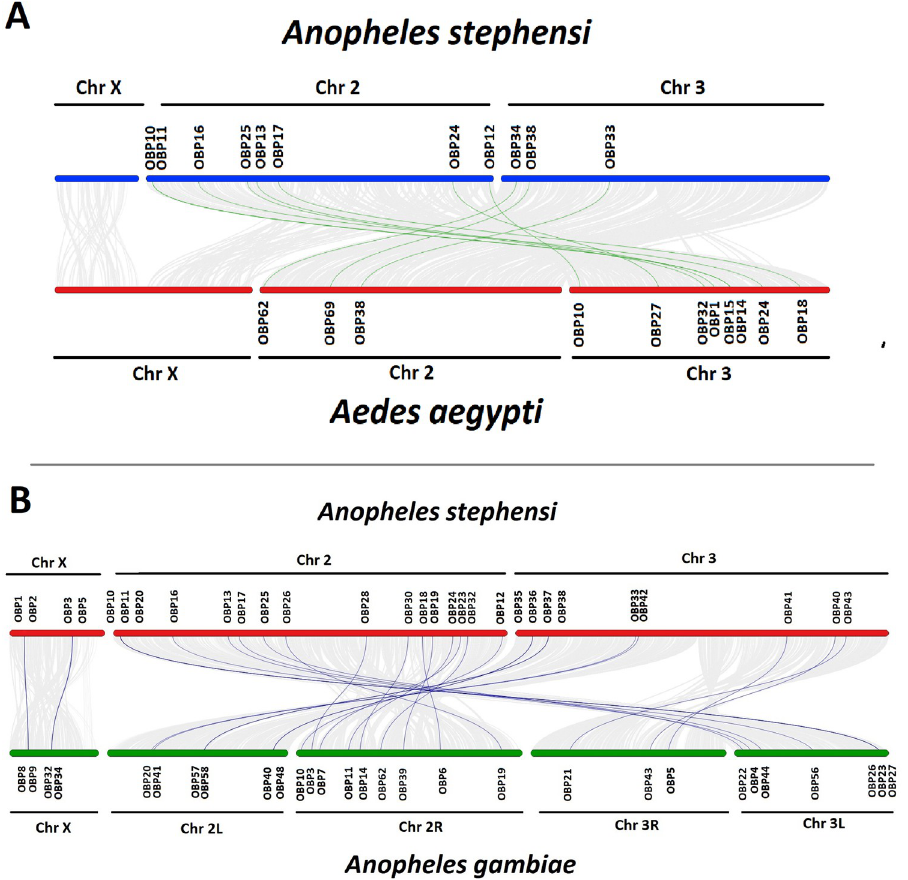
Fig 7. Synteny analysis of OBPs. Synteny analysis were carried out to find the collinear blocks between the OBPs of An . stephensi and OBPs of (A) Ae . aegypti and (B) Ae . gambiae . Chromosomes and chromosomal position of the OBPs have been shown. Green lines (A) show the syntenic relationship between the OBPs of An . stephensi and Ae . aegypti whereas blue lines (B) represent the syntenic relationship between the OBPs of An . stephensi and An . gambiae